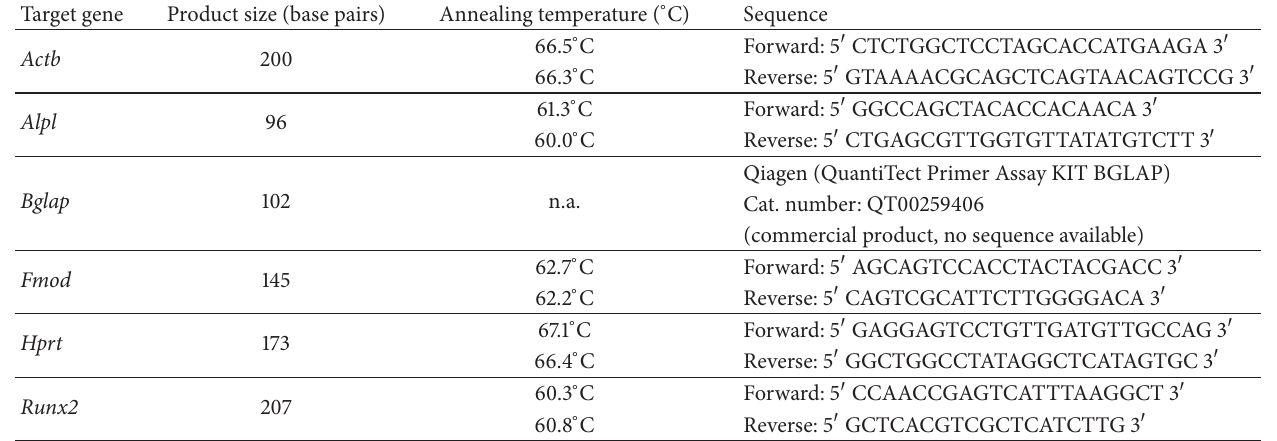
Table 1: Primer sequences of target and reference